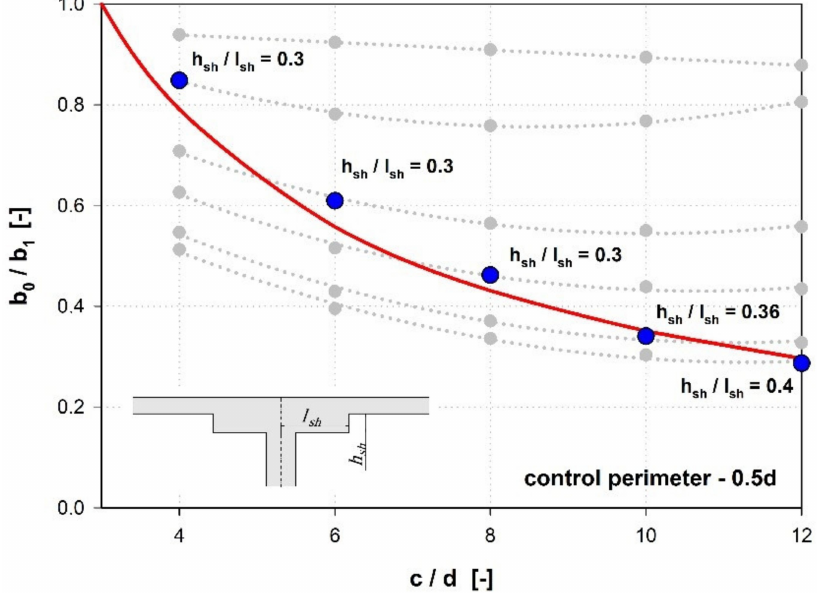
Figure 14. Determining the shear cap slenderness ( h sh / l sh ) at which the general MC2010 method for finding the effective length of control perimeter ( b 0 ) gives comparable results to the simplified method ( b 0,3 d